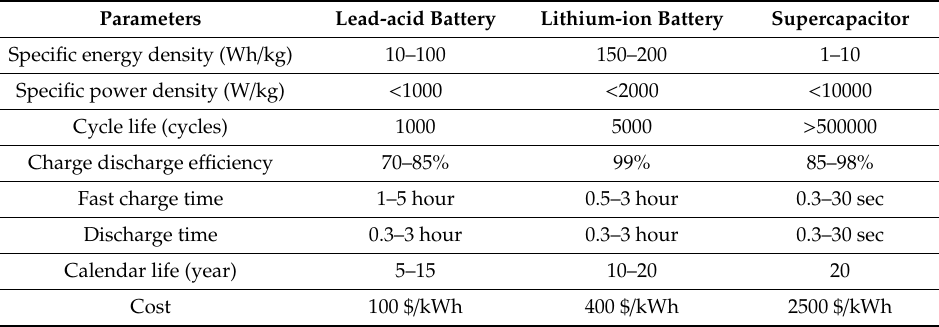
Table 2. Performance analyses of lead-acid, lithium-ion batteries and supercapacitors